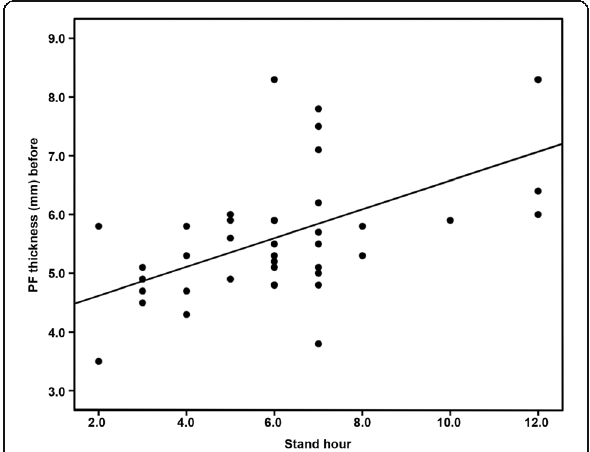
Fig. 2 Correlation between plantar fascia thickness before ESWT and the standing hours